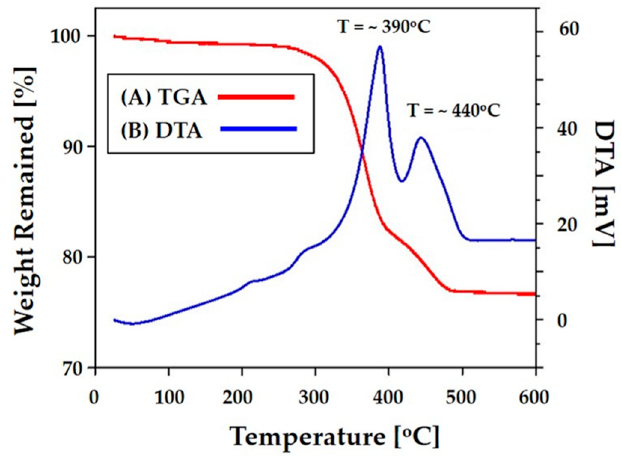
Figure 7. ( A ) TGA and ( B ) DTA results for the photo cured CaP sample as a function of